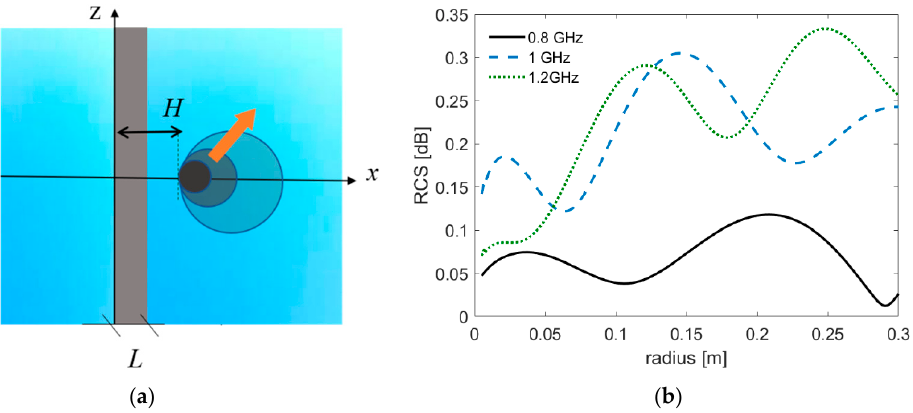
Figure 7. Radar cross section evaluated in the backscattering direction θ = 180°, with H = 50 cm, PEC target, L = 20 cm, ε r1 = 4 at three different frequencies.